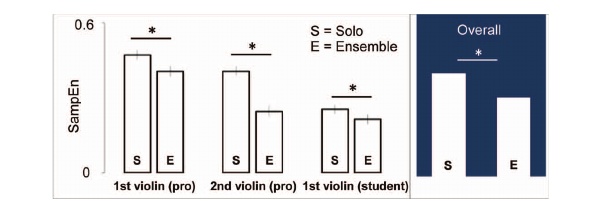
FIGURE 5 | Main effect of condition Solo vs. Ensemble . The histogram represents the amount of SampEn for Solo (S) and Ensemble (E) performances, separately for professional and student violinists. Asterisks denote significant differences. In blue background, the average over the two conditions for both musicians taken altogether.